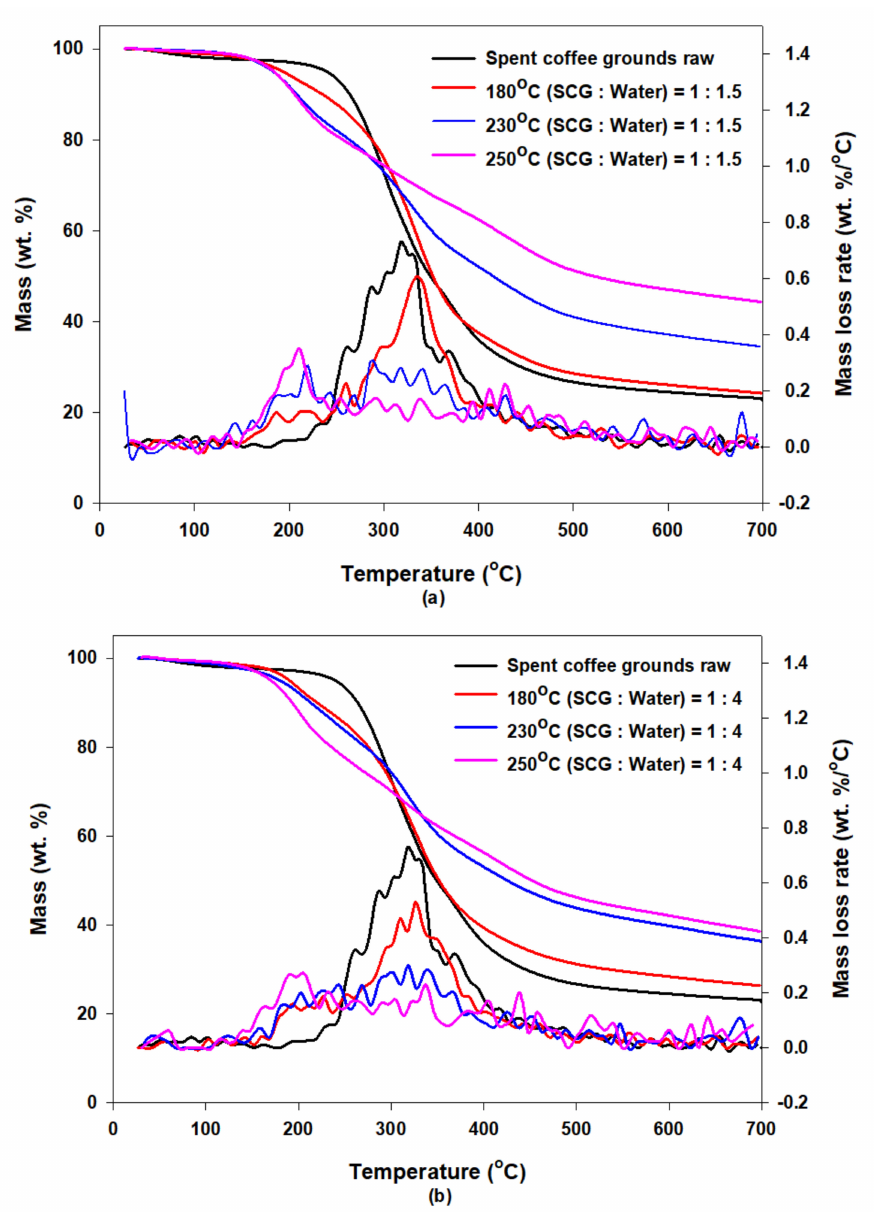
Figure 10. Thermogravimetric analysis (TGA) and derivative thermogravimetry (DTG) curves of raw and hydrothermally carbonized SCGs produced with different reaction temperatures and water contents. ( a ) SCG: water = 1:1.5; ( b )